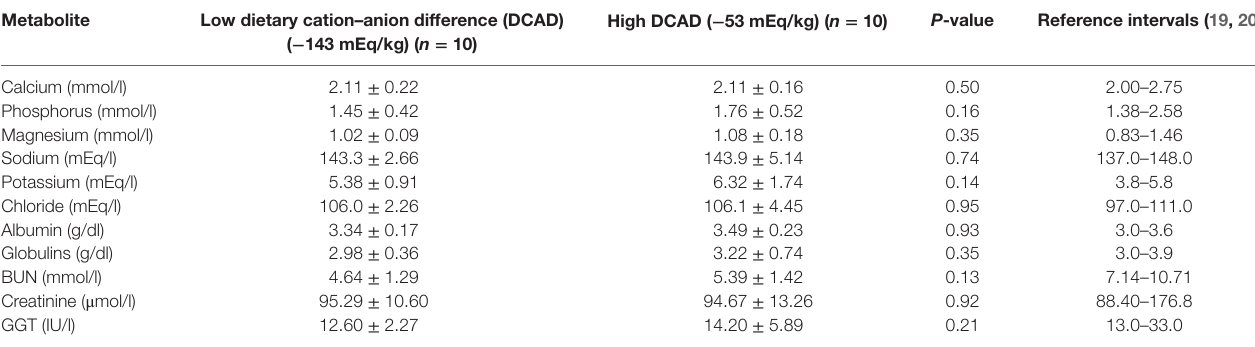
tabLe 4 | Mean ± SEM of laboratory results from prepartum dairy cows before and after changing their anionic diet and reference intervals for transition dairy cows. Metabolite Low dietary cation–anion difference (DCaD) High DCaD ( − 53 meq/kg) ( n = 10) P -value ( − 143 meq/kg) ( n = 10) Calcium